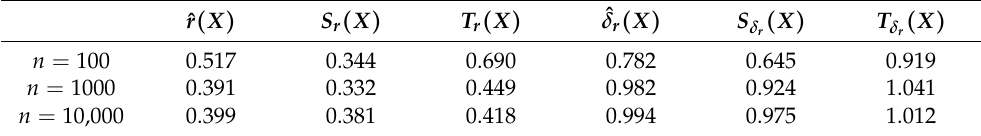
Table 2. Values of the estimates of the parameters ν and δ with the corresponding asymptotic confidence intervals for the true values of the parameters r = 0.4, ν = 1.7, s = 0.7, t = 1.5, δ = 1. ˆ ν ( X ) S ν ( X ) T ν ( X ) ˆ δ ν ( X ) S δ